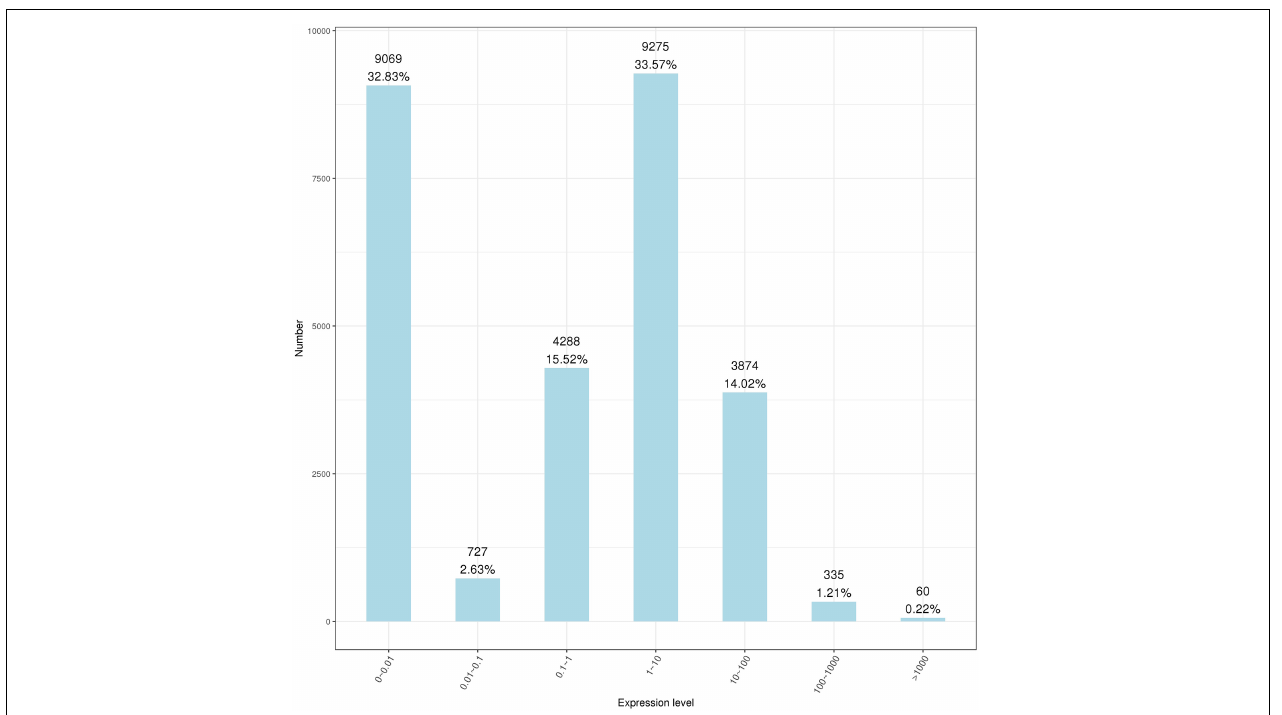
FIGURE 6 | Statistics showing the range of plant gene expressions during the B. altitudinis – Arabidopsis interaction. Horizontal coordinates represent the range of expression measures, and ordinates represent the number of genes in each expression interval.